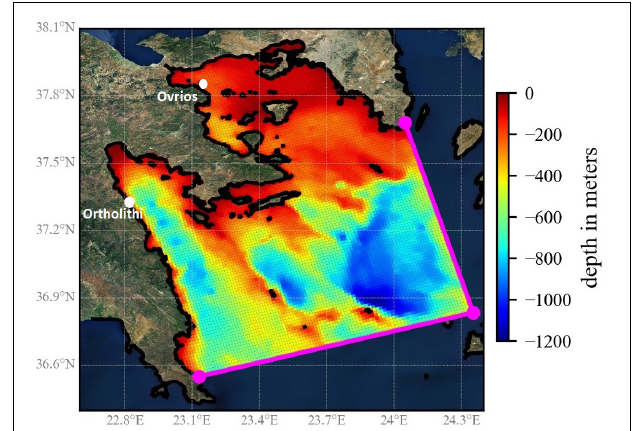
FIGURE 3 | Seabed level in model domain. Two gulf areas have characteristic bathymetry, Saronic Gulf with shallow depths of ∼ 200–300 m and Argolic Gulf with deep sea trench of ∼ 400–800 m depth. Two Magenta lines indicating the boundary of the model